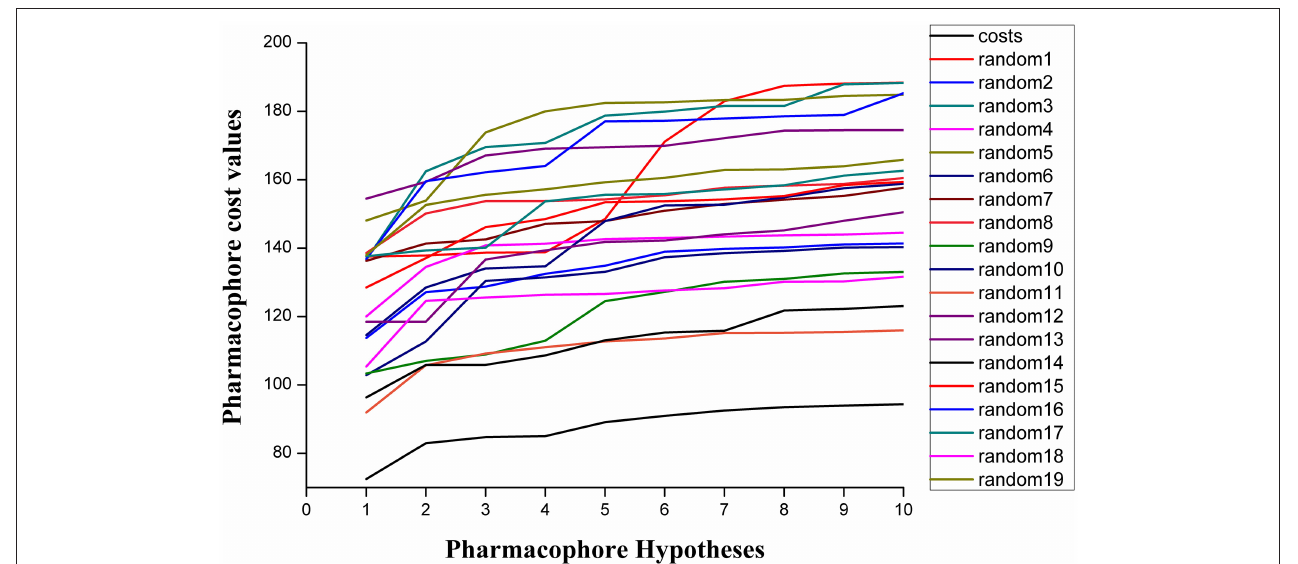
FIGURE 6 | The difference in costs between HypoGen runs and the scrambled runs. The 95% confidence level was selected.